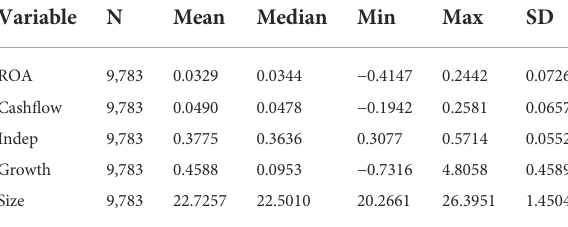
TABLE 2 Descriptive statistics of the dependent variable